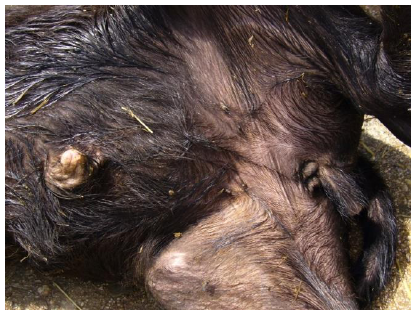
Figure 3. A MIRB male calf with abdominal cryptorchidism and penis craniocaudally